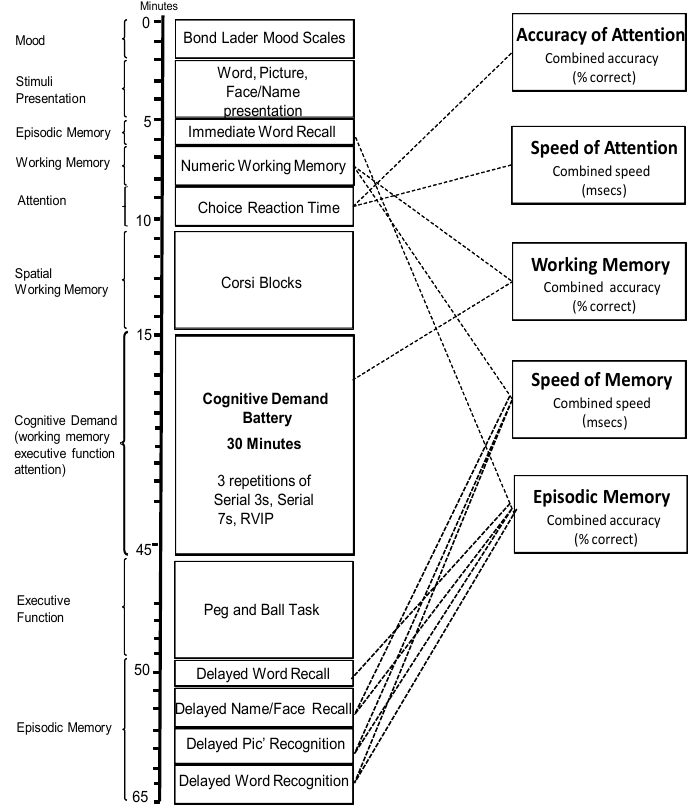
Figure 2. The running order of the individual cognitive assessments. The tasks are shown in order of completion with approximate timings. On the left, the “cognitive domain” assessed by the task is shown, and the boxes to the right show global measures into which data from several tasks can be